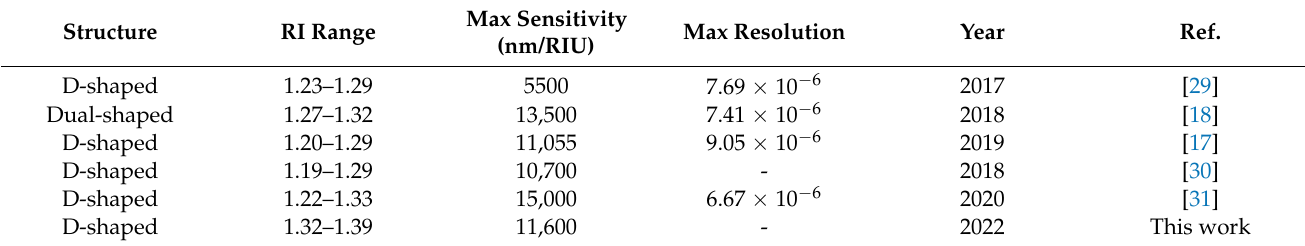
Table 2. Comparison of the proposed sensor with previous